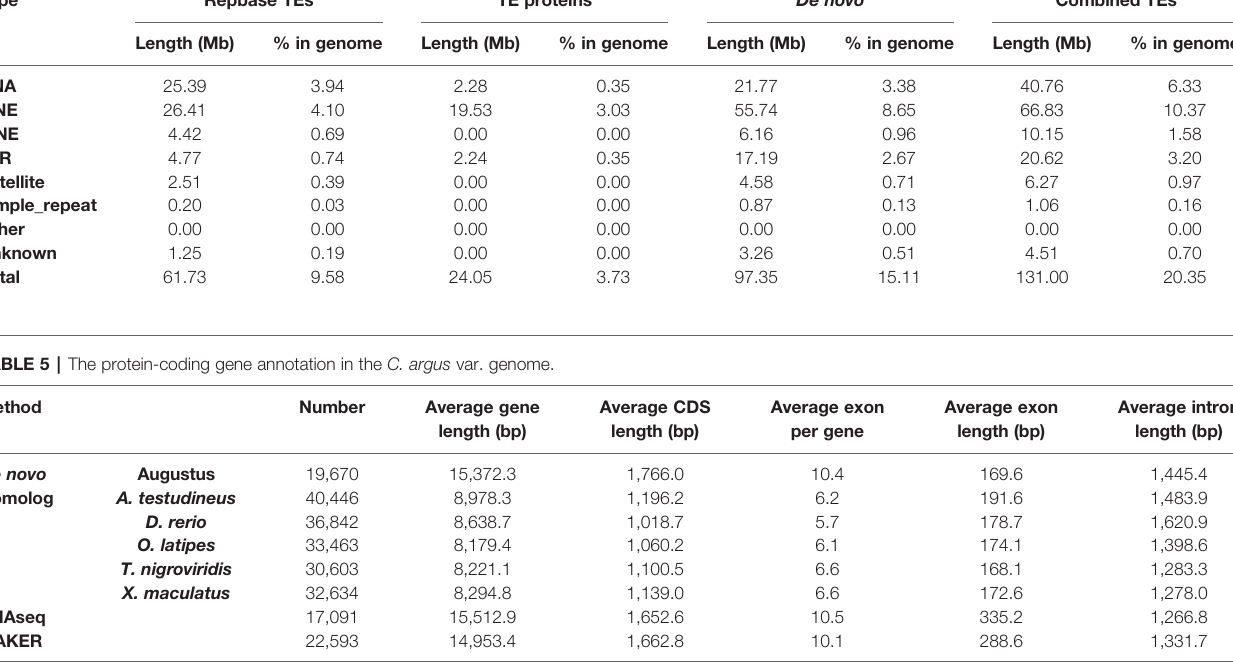
TABLE 4 | The repetitive element predicted from the C. argus var. genome. Type